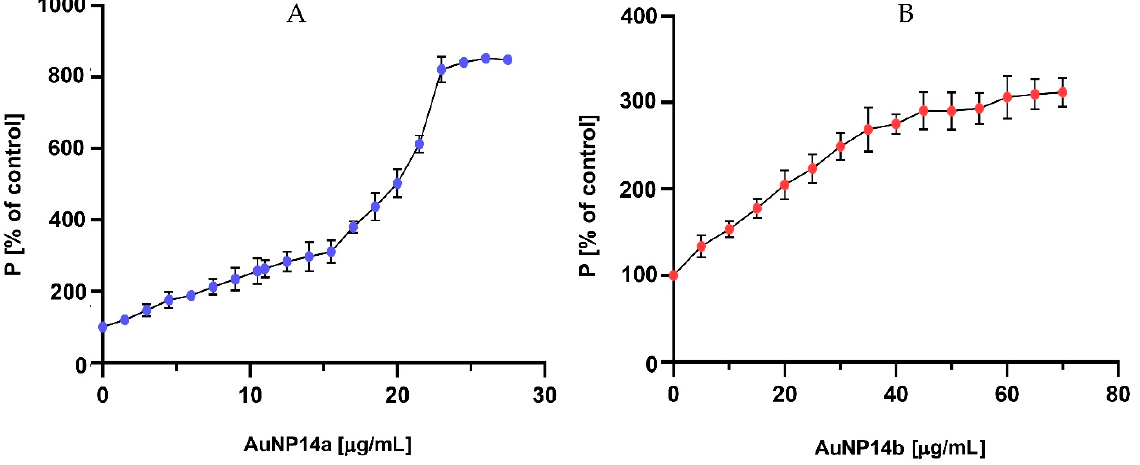
Figure 2. Changes in siRNA-FL fluorescence polarization after titration with ( A ) AuNP14a and ( B ) AuNP14b. Results of samples containing AuNPs presented as [%] of siRNA values without nanoparticles. siRNA concentration 1 µmol/L in sodium phosphate buffer 10 mmol/L, pH 7.4. λ exc = 485 nm, λ em = 516 nm. Results are mean ± standard deviation (SD), n = 3.